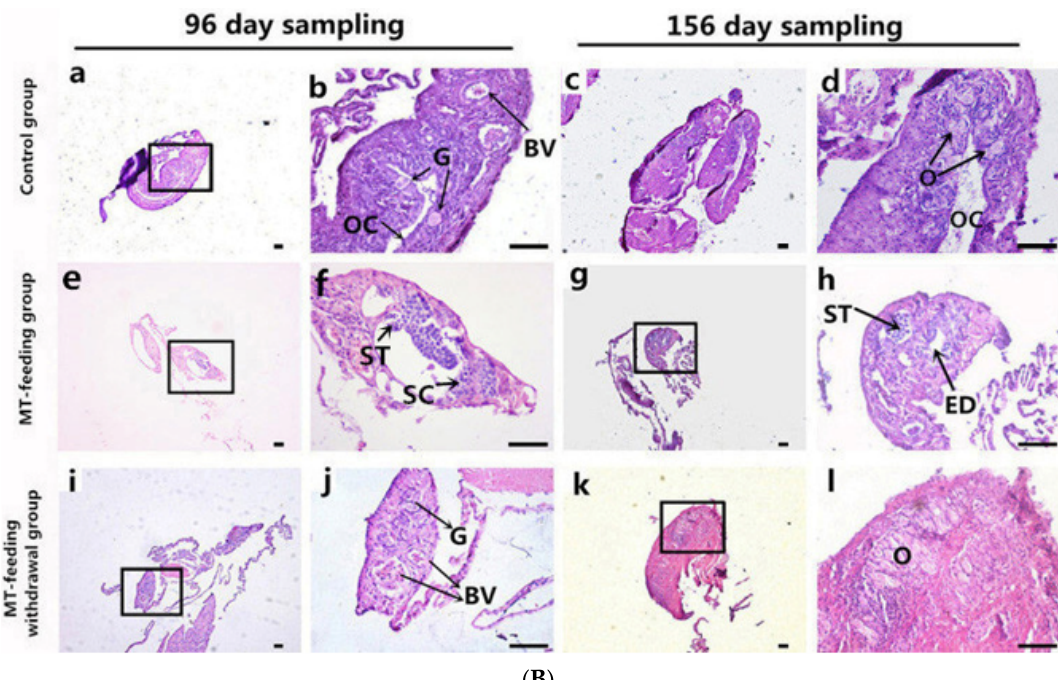
Figure 6. Gonad histology analysis after MT-feeding withdrawal. ( A ) Sampling time points. ( B ) Gonadal histology of the untreated control, MT-feeding and MT-feeding withdrawal groups. The panel b, d, f, h, j and l are high magnification pictures of a, c, e, g, i and k. G: gonia; OC: ovarian cavity; O: oogonium; ED: efferent dust; SG: spermatogonia; ST: spermatid; Scale bars, 25 μ m.